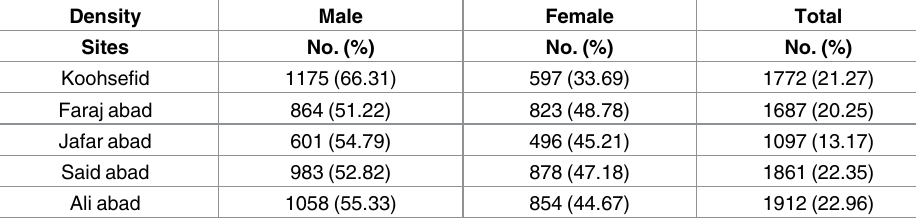
Table 1. The density of Phlebotomus papatasi collected in our area study before treatment.